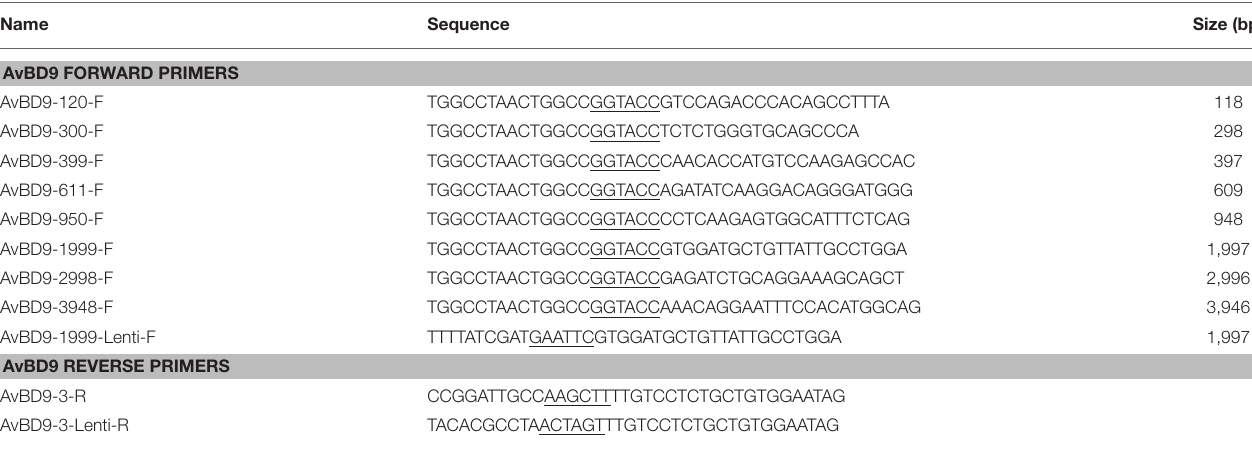
TABLE 1 | Primers used in this study a,b .